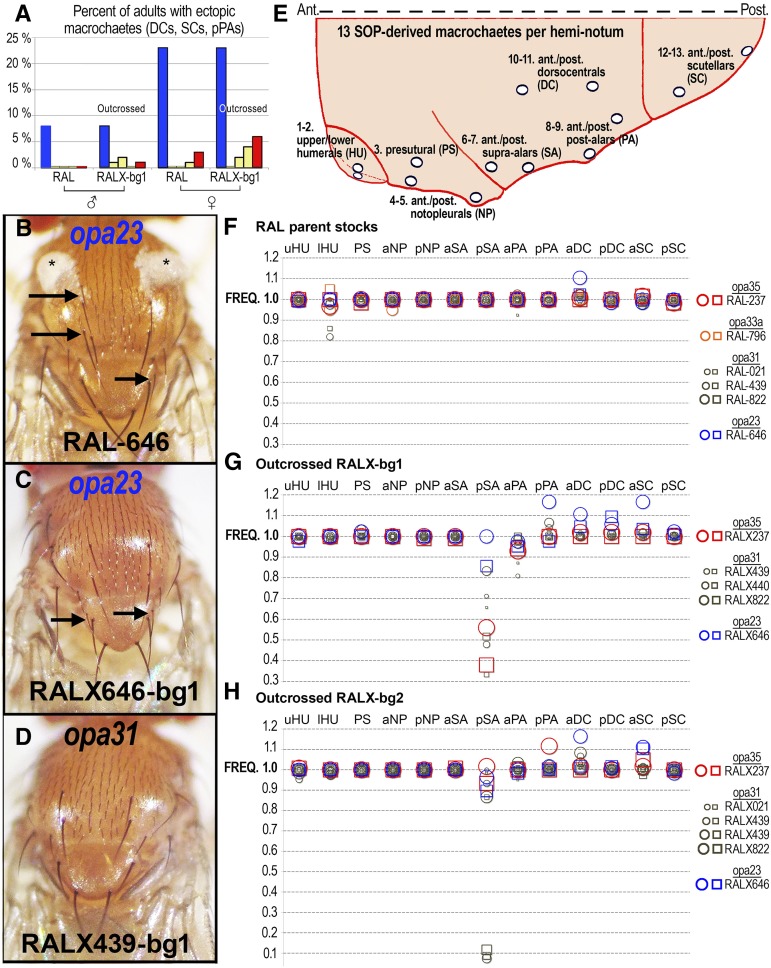
Rare Notch opa variants manifest macrochaete patterning defects. (A) Shown is a graph of the frequency of ectopic (i.e., duplicated) bristles on the adult thorax (DCs, dorsocentral macrochaetes; SCs, scutellar macrochaetes; pPAs, posterior postalars) of male (left) and female (right) RAL stocks and outcrossed RALX-bg1 lines, carrying different opa variants at Notch. This defect is most pronounced for the RAL-646 and RALX646-bg1 lines (blue bars) carrying the rare opa23 variant, but some intensification is also seen for the RALX237-bg1 line (red bars) carrying another rare variant, opa35. Lines carrying wild-type opa31 alleles in either the parent RAL stocks or the RALX-bg1 derivative lines based on RAL-439, RAL-440, and RAL-822 (yellow bars) rarely have ectopic bristles. (B–D) Shown are representative adult nota with ectopic bristles (arrows) in the parent RAL-646 (B) and the outcrossed RALX646-bg1 line (C), but not the RALX439-bg1 line (D). Cuticle fluff (asterisks in B) is frequently seen in the RAL-646 flies. (E) Cartoon of hemi-notum and its 13 macrochaetes, abbreviated as follows: (1–2) upper and lower humerals (uHU, lHU); (3) presutural (PS); (4–5) anterior and posterior notopleurals (aNP, pNP); (6–7) anterior and posterior supra-alars (aSA, pSP); (8–9) anterior and posterior postalars (aPA, pPA); (10–11) anterior and posterior dorsocentrars (aDC, pDC); and (12–13) anterior and posterior scutellars (aSC, pSC). Anterior is to the left. Posterior is to the right. Top of image is the dorsal midline. (F) Frequency (FREQ) of macrochaete occurrence in parent RAL stocks (different colored shapes) for female (circles) and male (squares) flies. (G) Frequency of macrochaete occurrence in 5× outcrossed RALX stocks using FM7c males (bg1). Outcrossed lines are homozygous for the RAL X. The failure to form pSA is also seen in the FM7 balancer lines (data not shown). (H) Frequency of macrochaete occurrence in 5× outcrossed RALX stocks using FM7a males (bg2). Outcrossed lines are homozygous for the RAL X. These data show that the RALX646 (blue opa23) and RALX237 (red opa35) outcrossed lines produce ectopic posterior postalar, dorsocentral, and scutellar macrochaetes.